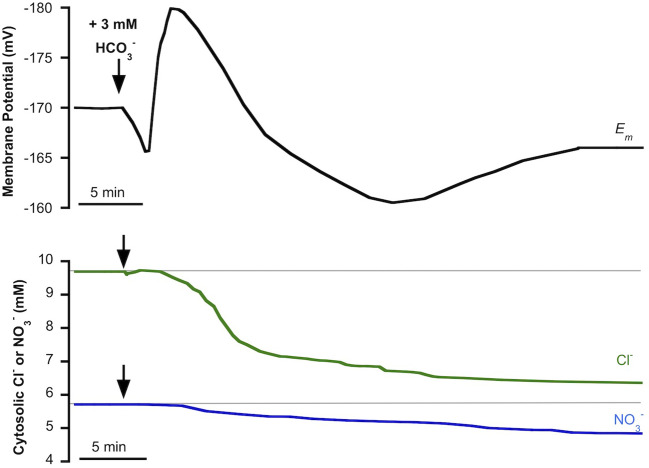
Effect of the addition of 3 mM HCO3− on the plasma membrane potential (Em, mV), cytosolic chloride (Cl−, mM) or cytosolic NO3− (NO3−, mM) measured in mesophyll leaf cells of Posidonia oceanica. Assay medium consisted of natural seawater and arrows indicate the addition of 3 mM HCO3−. Traces are representative examples from five independent recordings using intracellular Cl−-selective (green trace) or NO3−-selective (blue trace) microelectrodes, respectively. Auxiliary grey lines indicate the normal cytosolic Cl− or NO3− concentrations before HCO3− addition. Mean values and statistics are indicated in the text and in 
Table 1
.